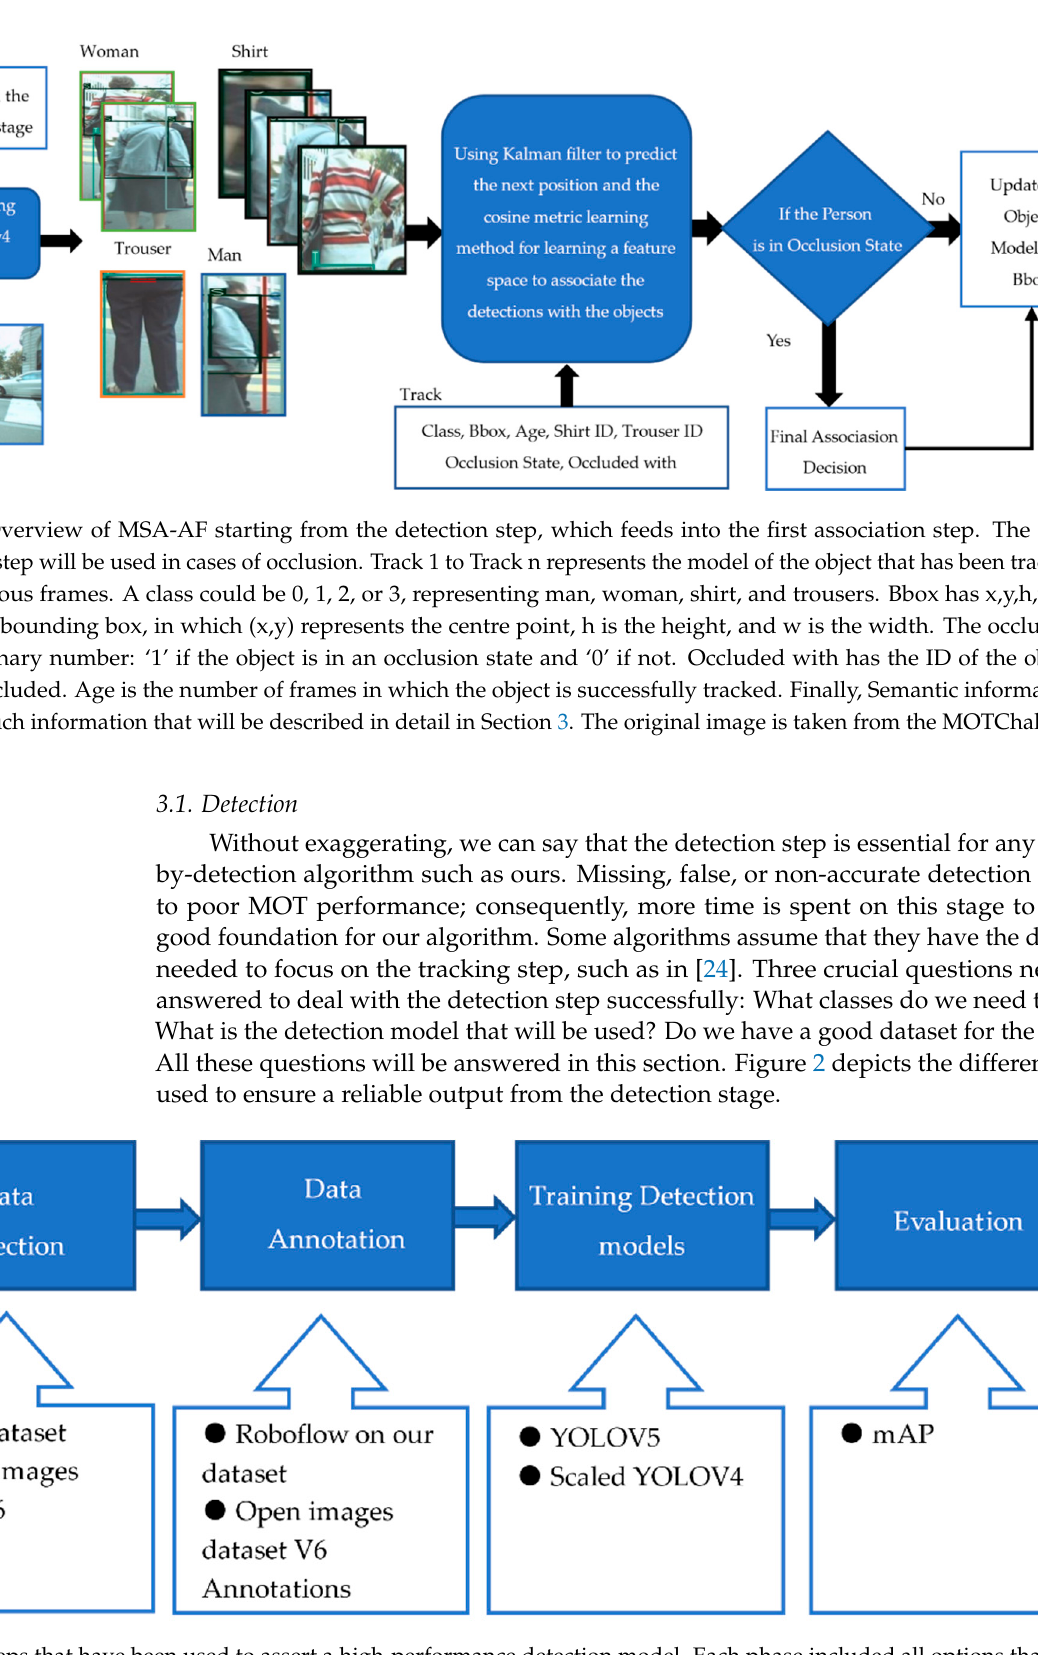
Figure 2. Steps that have been used to assert a high-performance detection model. Each phase included all options that we used for the comparison in order to get the best detection results.